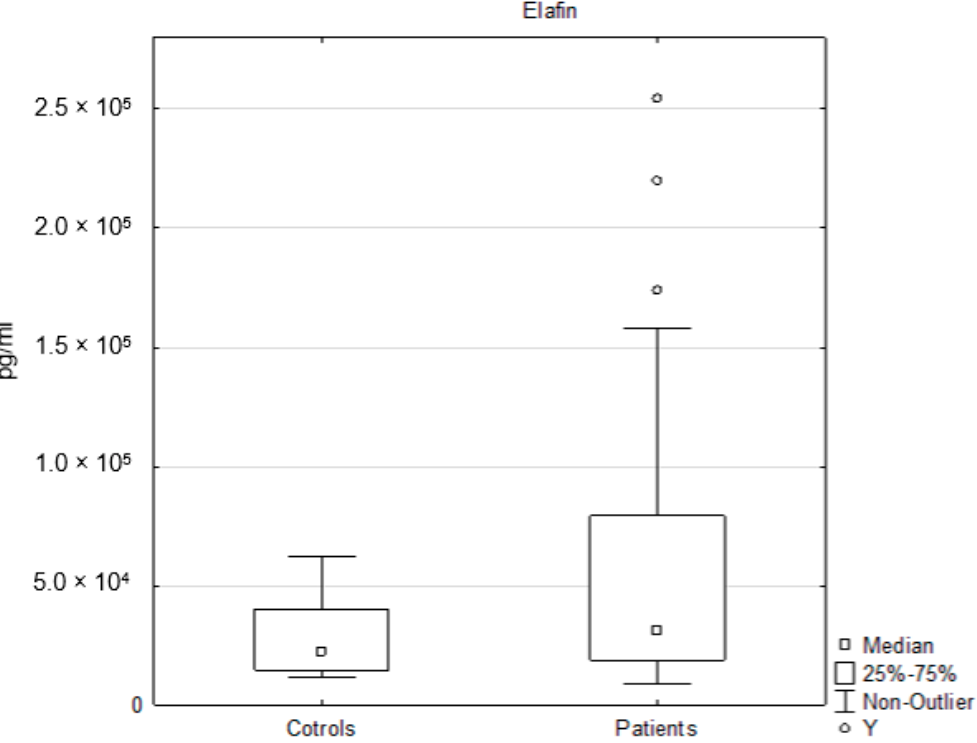
Figure 3. The levels of serum elafin in the controls and in the patients. Y indicates an outlier. An outlier is any data point value > 75th percentile + 1.5 * (75th percentile–25th percentile) or any data point < 25th percentile–1.5 * (75th percentile–25th percentile), p < 0.05.